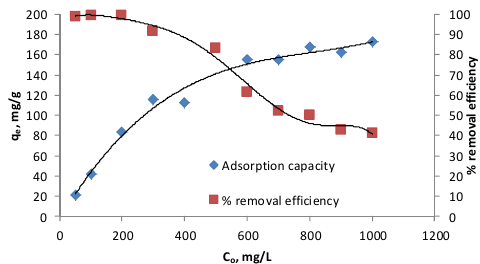
Fig.2. Effect of initial concentration on adsorption of MB on